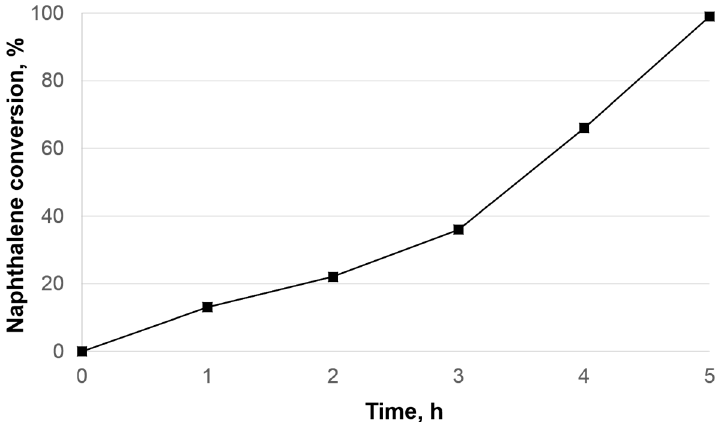
Figure 9. Kinetic curve of naphthalene hydrogenation in presence of PAF ‐ 30 ‐ NiMoS catalyst. Reaction conditions: 380 °C, 5 MPa H 2 , catalyst (50 mg), naphthalene (80 mg), benzene (2 mL).